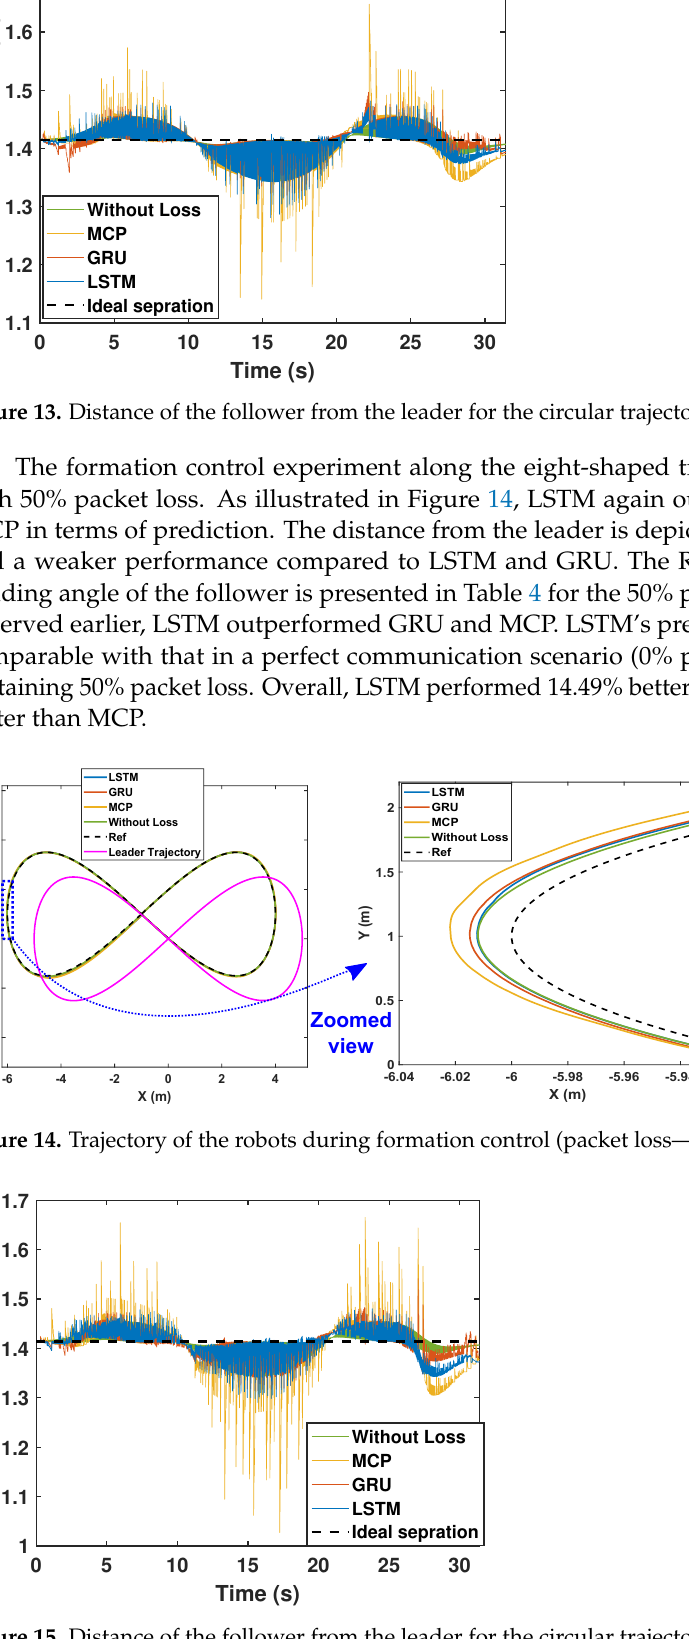
Figure 15. Distance of the follower from the leader for the circular trajectory (packet